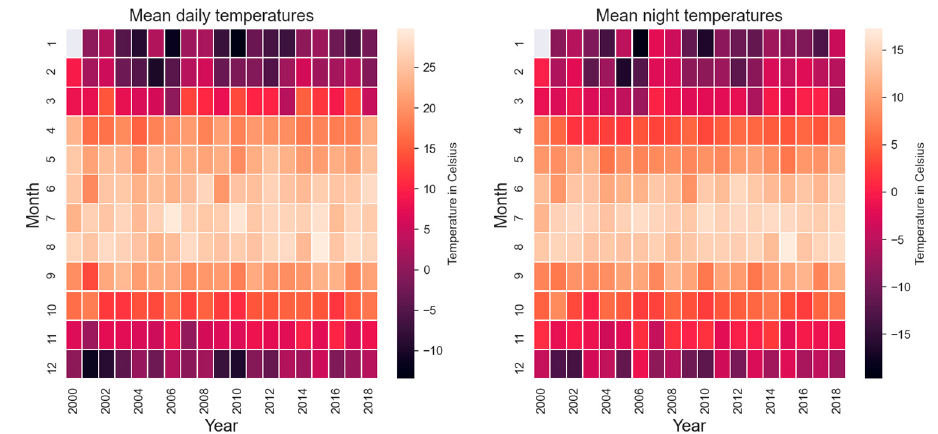
Figure 5. Mean daily and nightly temperatures for Czernichow.